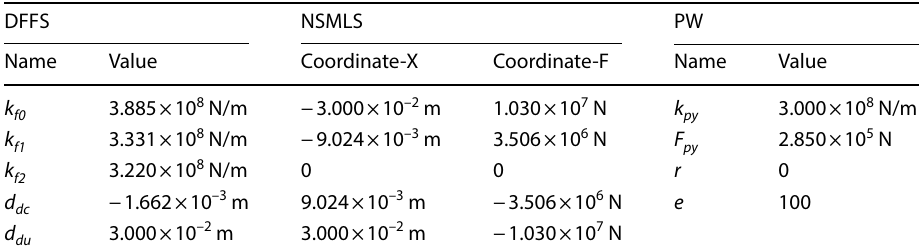
Table 5 Modelling parameters for 3 link components output by running coded algorithm